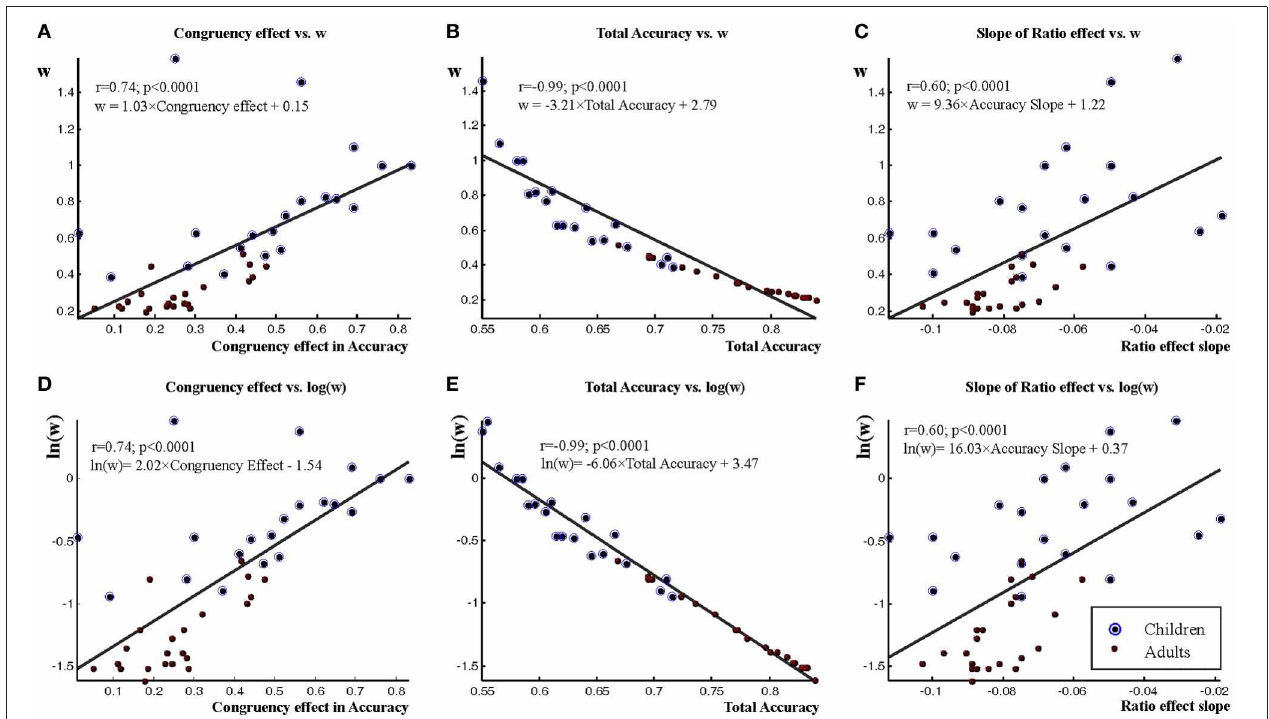
FIGURE 6 | The relationship of some measures and w . The relationship of the congruency effect and w is shown in A and D (log transformed w data). The relationship of total accuracy and w is shown in B and E (log transformed